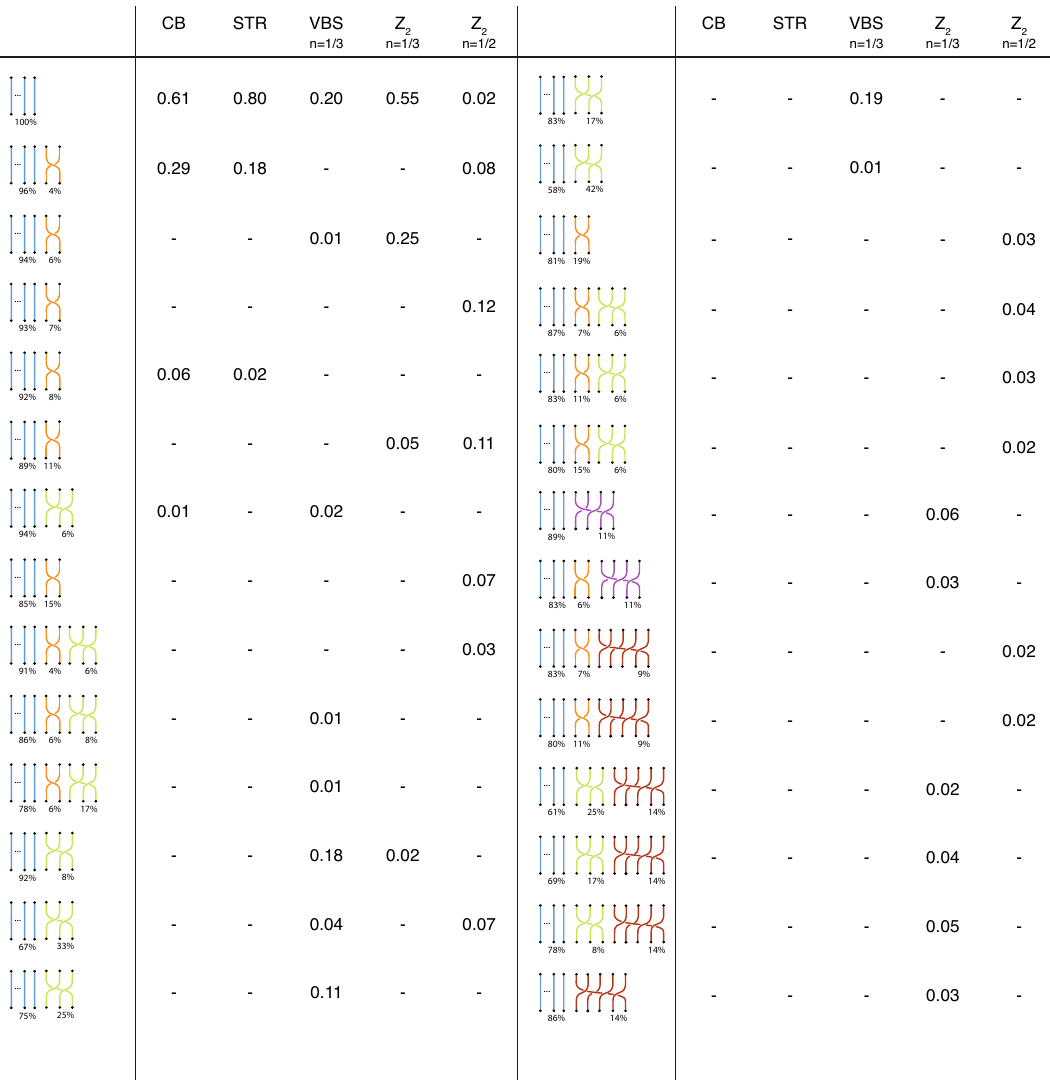
Figure 3. Arrangement of permutation cycles in ground-states of different insulating quantum phases. Numbers in the table represents the probability of each arrangement to appear in the related phase. The percentage in the diagrams refers to the components of (cid:31) p φ (i.e. the fraction of particles participating in permutation cycles of that length). CB for L = 10 and V / t = 20 ; STR for L = 12 and V / t = 20 ; VBS at n = 1 / 3 for L = 6 unit cells and V / t = 30 ; Z 2 at n = 1 / 3 and n = 1 / 2 for for L = 6 unit cells and V / t = 15 permutation cycles corresponding to straight worldlines (blue), 2 β -long permutation cycles corresponding to two worldlines braiding together (orange), 3 β -long permutation cycles and longer corresponding to three or more worldlines braiding together (green, violet and brown for 3 β , 4 β and 5 β respectively). We notice that for CB and STR phases more than 60% of the configurations are trivial braids while most of the remaining ones only possess one or few permutation cycles of length 2 β . In the VBS case, 57% of configurations possess permutation cycles of length 3 β consistent with local resonances harbored in isolated hexagons occupied by three particles 12,20 . Finally, permutation cycles of length 4 β and 5 β only appears in the Z 2 phase with, in some cases, 30–40% of particles involved in permutation cycles longer than 1 β . Though with the current available tools one is unable to detect braiding between permutation cycles, the observation that longer permutation cycles only appear in the Z 2 phase and a considerable number of particles are involved in them is consistent with the presence of more complicated braids which extend throughout the lattice as discussed in “Braiding properties of worldline configurations” section. Overall, all these observations are consistent with our expectations, as discussed in the previous section. In Fig. 4, we plot the spectrum of the superfluid phase (SF) ground-state. As expected, we notice that configu- rations featuring permutation cycle lengths (cid:31) /β ∼ N are the most probable, that is, configurations are such that most worldlines participate to the same permutation cycle. In Fig. 4, we also sketch some of the most probable permutation cycle lengths. The percentages in the sketches represent the fraction of particles involved in the permutation cycles.